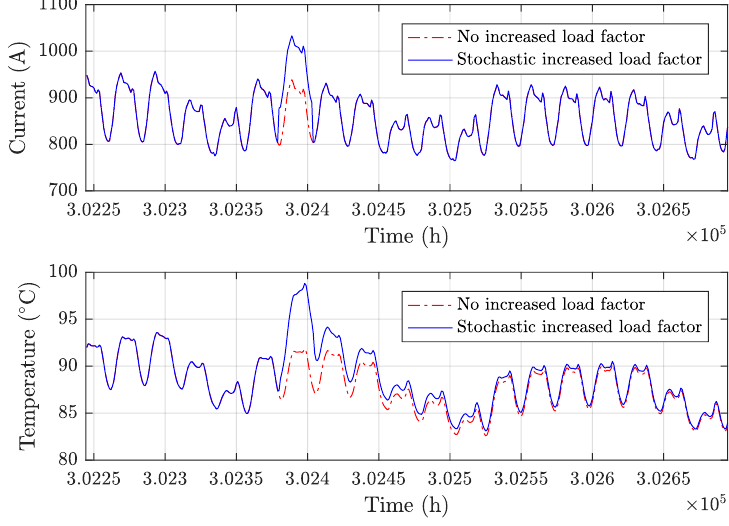
Figure 23. Effect of stochastic load factor increases during the prognostics